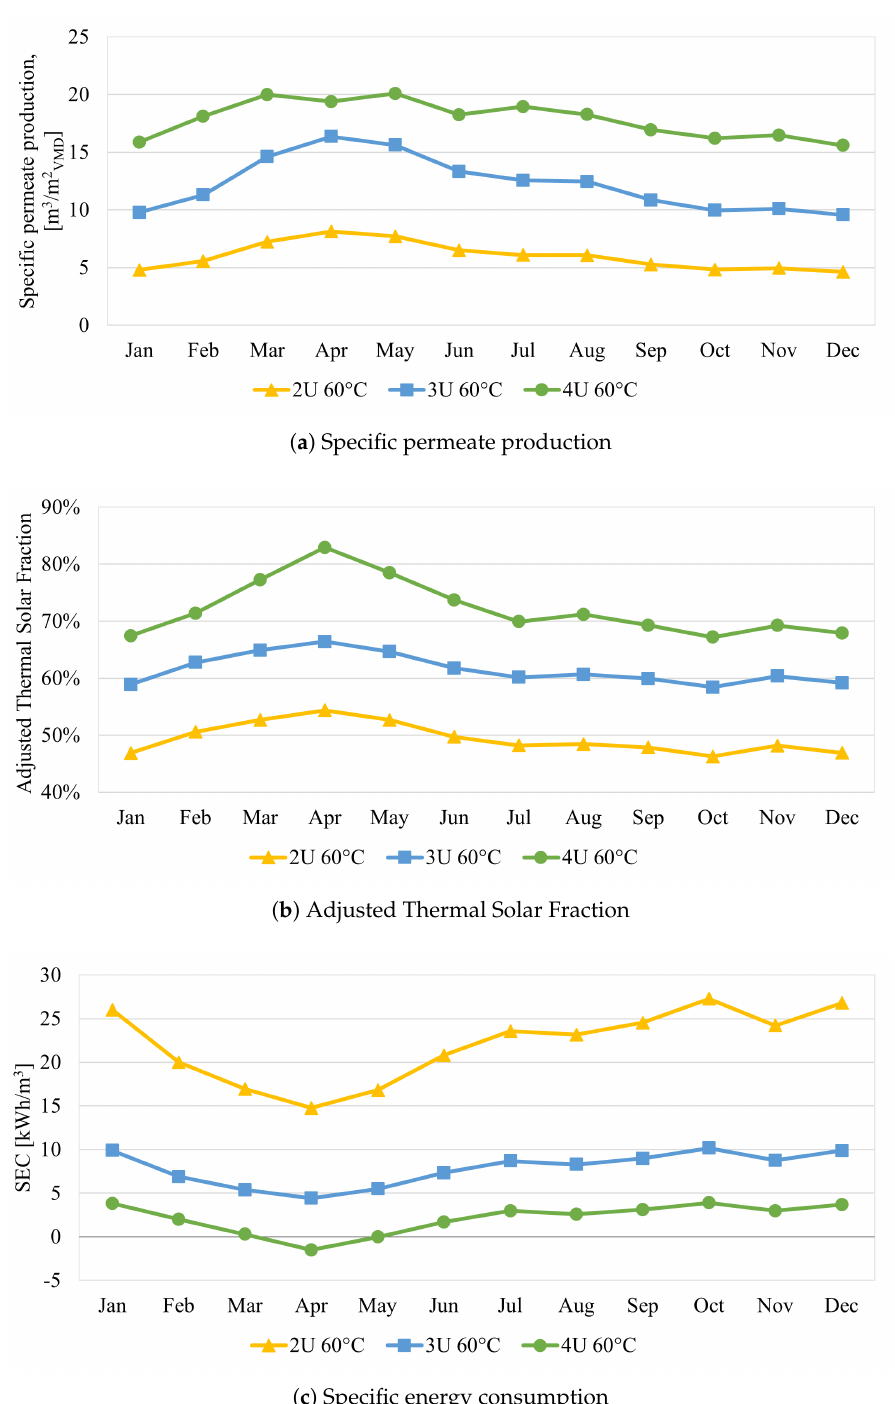
Figure 4. Effect of variation of CPVT surface area on system’s